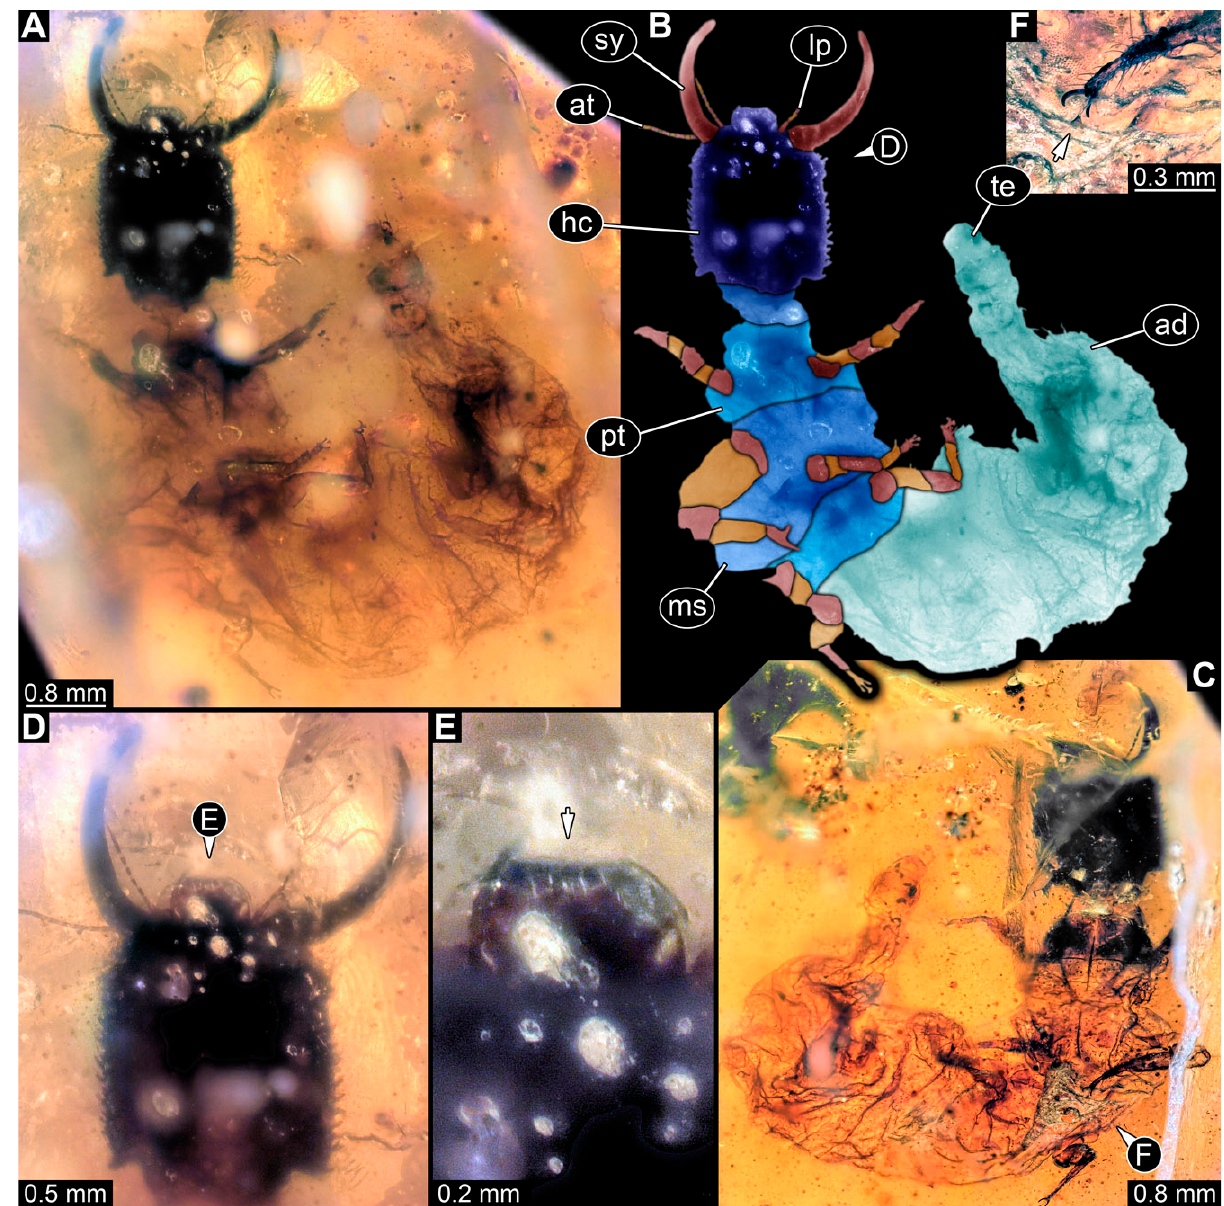
Figure 15. Specimen 76 (PED 1627); Myanmar amber. ( A ) Dorsal view. ( B ) Dorsal view, colour- marked. ( C ) Ventral view. ( D ) Close-up of head capsule, dorsal view. ( E ) Close-up of labrum, dorsal view; arrow marks labrum. ( F ) Close-up of second locomotory appendage; arrow marks empodium. Abbreviations: ad = abdomen; at = antenna; hc = head capsule; lp = labial palp; ms = mesothorax; mt = metathorax; pt = prothorax; sy = stylet.